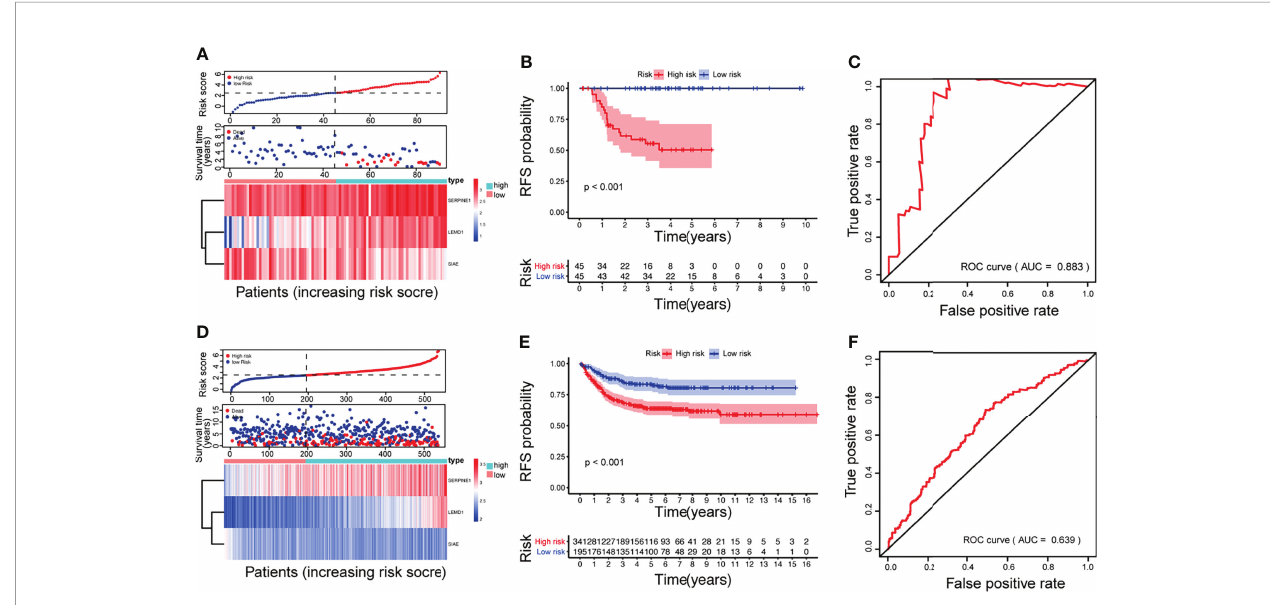
FIGURE 3 | Construction and validation of the CRC relapse model: The multigene signature was based on GSE33113 (A – C) and validated in GSE39582 (D – F) . (A, D) survival time distribution of CRC patients and gene risk heat maps; (B, E) Kaplan – Meier survival analysis between patients at low- and high-risk of relapse; (C, F) ROC curves at 5 years.